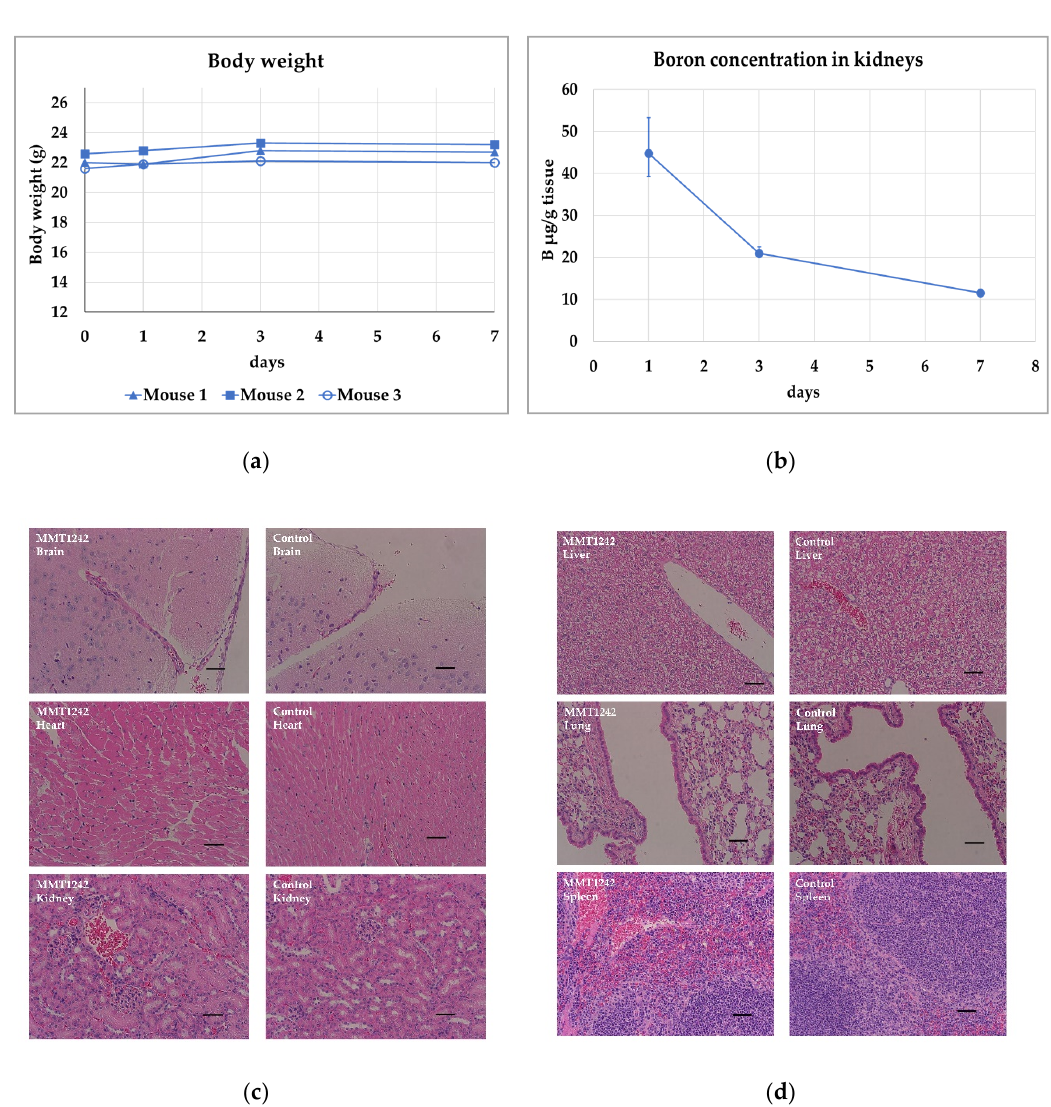
Figure 6. Toxicity study using healthy mice. All mouse weights were unchanged for 7 days after intravenous injection of MMT1242 ( a ). The boron concentration in mouse kidneys showed good clearance within 7 days after injection of MMT1242 ( b ). HE-stained tissue specimens of kidney, heart, lung, liver, and spleen from mice showing no toxic damage ( c , d ). The scale bar is 50 μm.